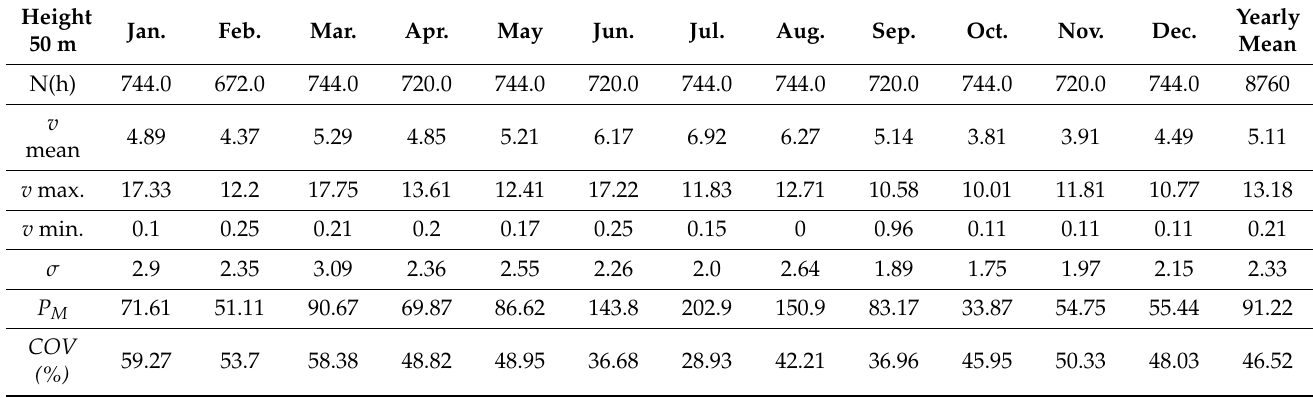
Table 8. The monthly of mean wind speed in (m/s) and ( COV ) coefficient of variation at 50 m height during the period